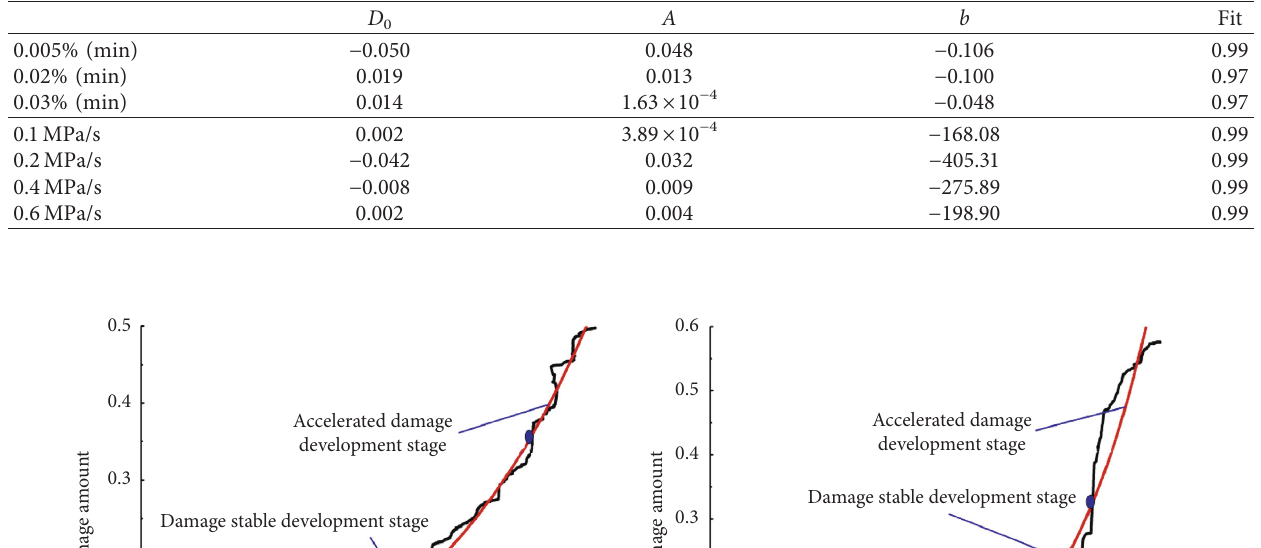
Table 2: Specific parameters of the theoretical curve.